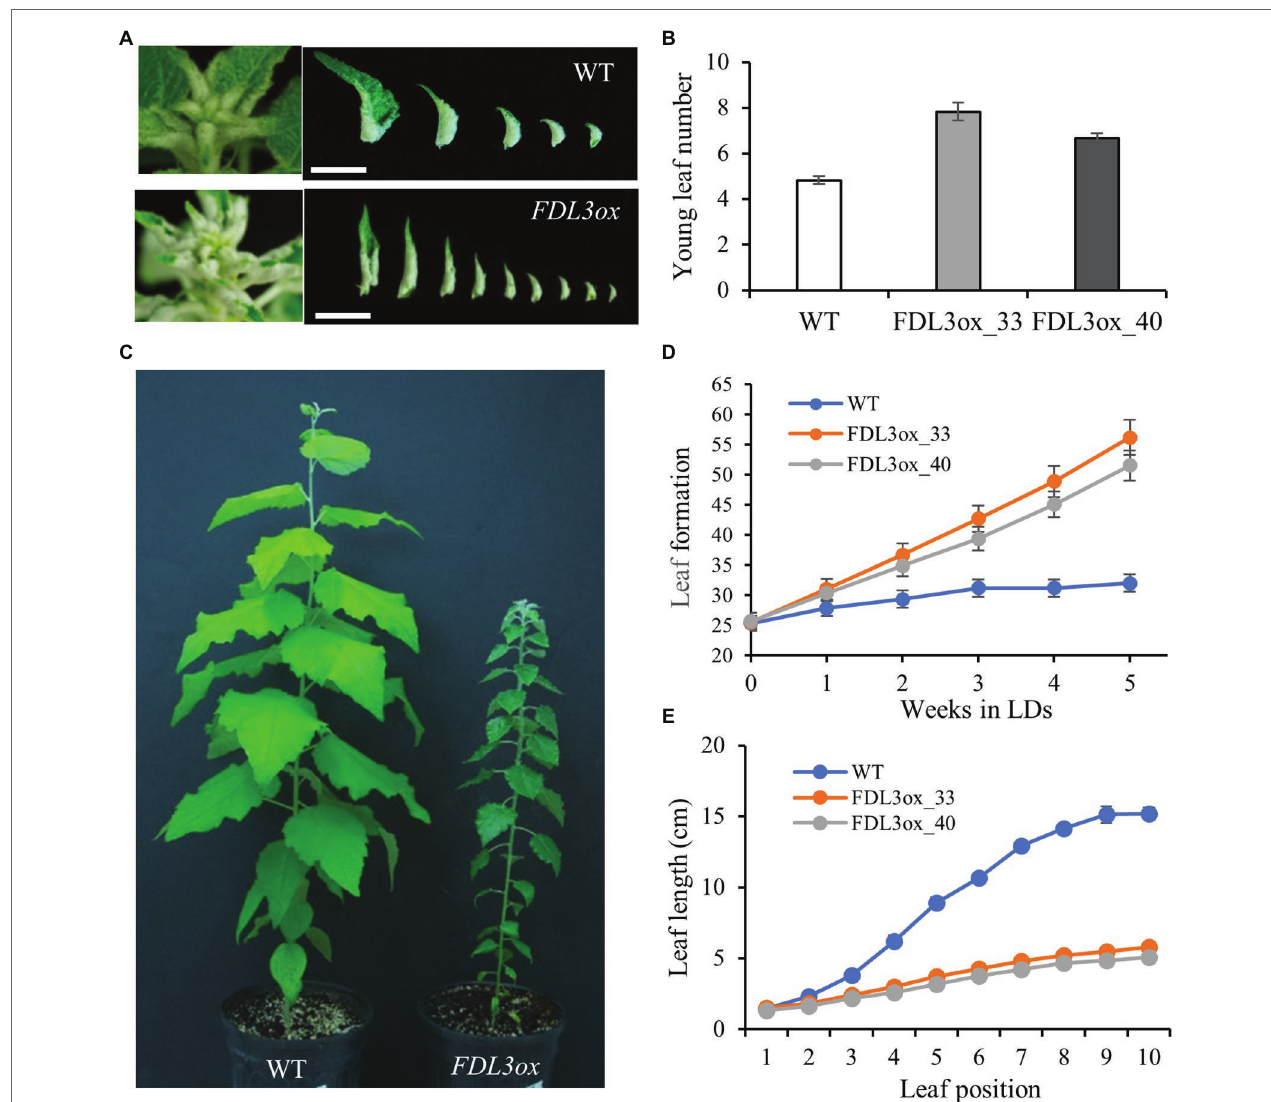
FIGURE 4 | Overexpression of FDL3 accelerates leaf production, but represses leaf growth in long day (LD) conditions. Ramets of two FDL3ox events and WT were grown in a growth chamber under 16-h photoperiods for 2 months. (A) Shoot apices and young rolled leaves of a FDL3ox plant compared with that of a WT plant. Scale bars = 1 cm. (B) Number of young rolled leaves. (C) Representative WT and FDL3ox trees (D) Emergence of new leaves (leaf lamina longer than 1 cm) over time. Leaf number was counted weekly, beginning 3 weeks after transplantation. (E) Progression of leaf length with position on the shoot. Leaf position 1 is the youngest leaf whose lamina is longer than 1 cm. (B,D,E) Means ± SE ( n = 6) for two FDL3ox events (33 and 40) and